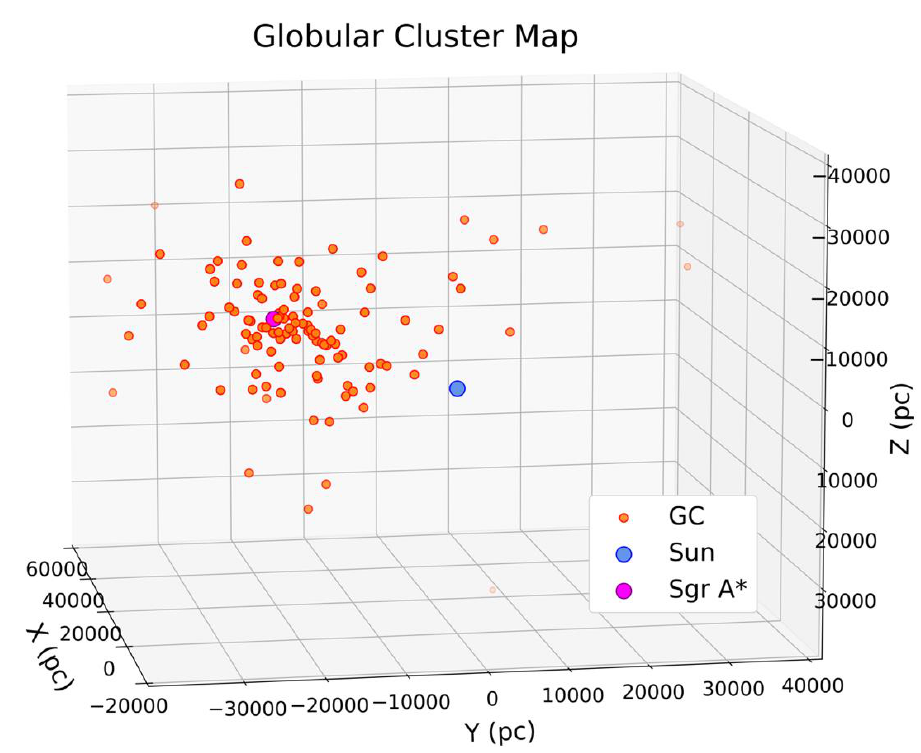
Figure 6. Globular cluster map for pinpointing the location of the Solar System.